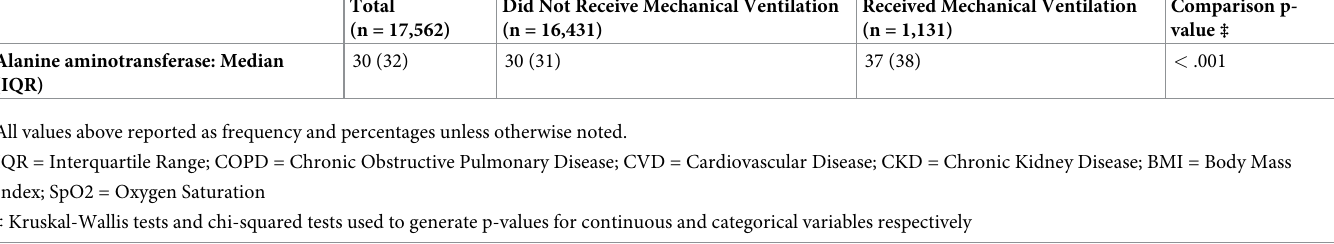
S6 Tables in S1 File. Frequencies of reason for readmission by ventilation group are shown in Table 3. Frequencies of reason for readmission by ventilation group in the propensity-matched sample are shown in S7 Table in S1 File. To increase interpretability of the regression model, several categories of reason for read- mission were collapsed. The most frequently occurring categories (i.e., COVID-19, abnormal symptoms/labs, cardiovascular, respiratory, and infectious disease) were maintained. All other categories were collapsed into “other.” The “other” group was set as the reference category for the multinomial logistic regression. Variables that were not balanced after propensity score matching (ASD greater than or equal to 0.10) were included as covariates. Results for the mul- tinomial regressions are displayed in Table 4. Characteristics of the readmitted sample are pre- sented prior to (S5 Table in S1 File) and after propensity score matching (S6 Table in S1 File).